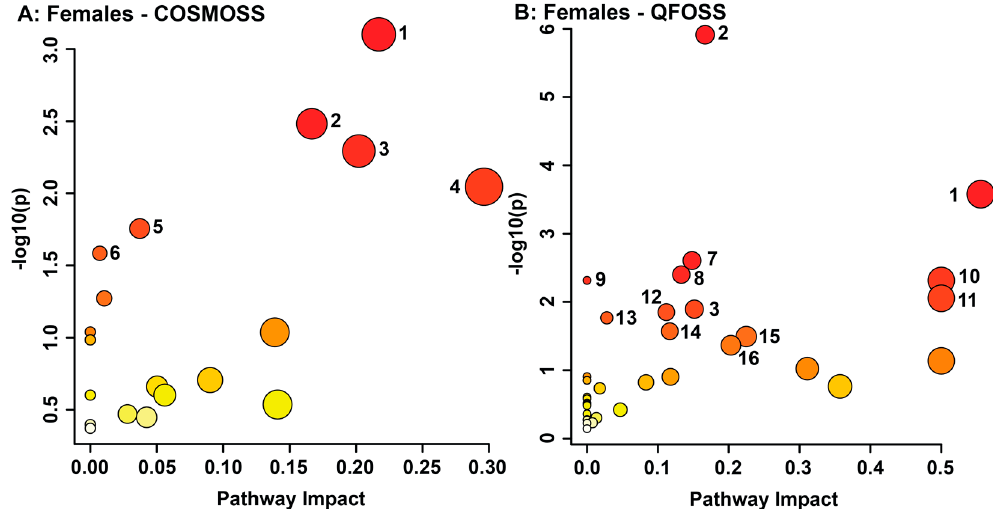
Figure 4. Metabolomic Pathway Topology Analysis of females whose mothers experienced composite subjective distress ( A ) and objective hardship ( B ) conducted utilizing bins identified as significantly altered by VIAVC. A higher value on the y-axis relates to a lower p -value, with 1.3 referring to a p -value of 0.05. The x-axis provides a measure of the predicted impact on the metabolic pathway due to the identi fi ed metabolites. The color of each circle is indicative of its p -value, whereas the size of each circle relates to its impact factor, with a darker color and larger circle indicating a lower p -value and greater impact factor, respectively. Only the pathways with a signi fi cant p -value (less than or equal to 0.05) are numbered and refer to the following metabolic pathways: (1) Glycine, serine, and threonine metabolism; (2) Aminoacyl-tRNA biosynthesis; (3) Galactose metabolism; (4) Cyste- ine and methionine metabolism; (5) Tyrosine metabolism; (6) Pantothenate and CoA biosynthesis;